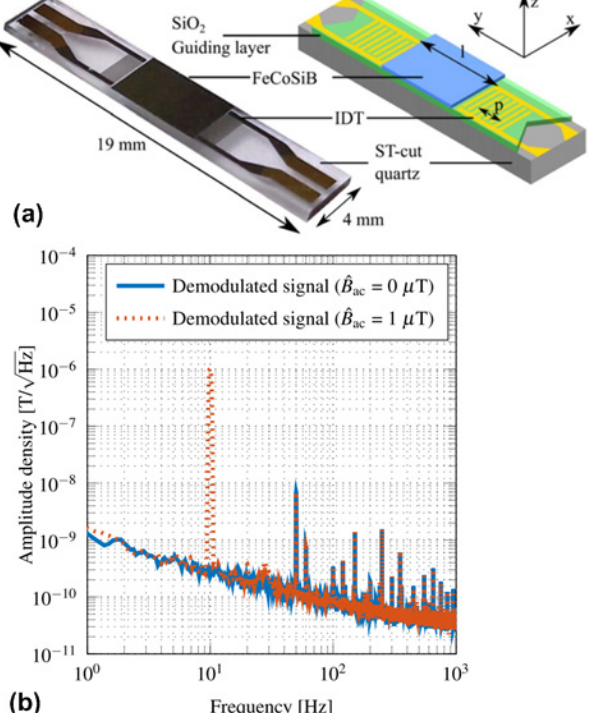
Figure 8. ( a ) A sensor design of the Love wave surface acoustic wave sensor based on ST-cut quartz substrate and a 4.5 µm SiO 2 guiding layer; and ( b ) equivalent magnetic noise floor of the output substrate and a 4.5 µ m SiO 2 guiding layer; and ( b ) equivalent magnetic noise floor of the signal shows the frequency dependent LOD. An equivalent magnetic noise of 250 pT/Hz 1/2 at 10 Hz